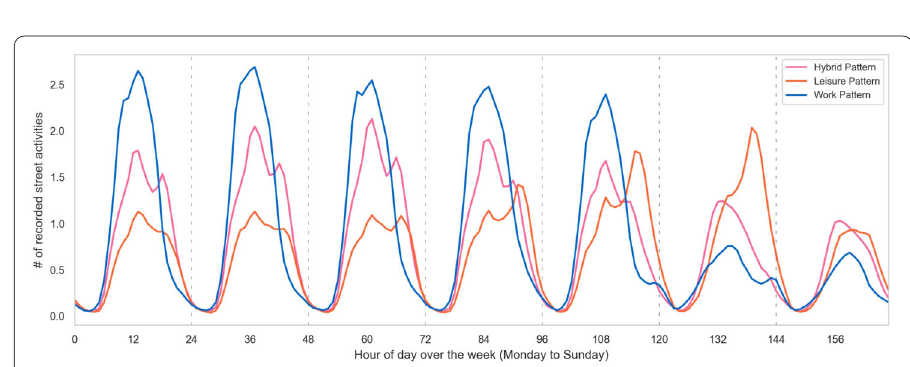
Figure 4 Identification of pattern clusters. The line graphs show the average street activity rhythms of Work, Hybrid , and Leisure pattern